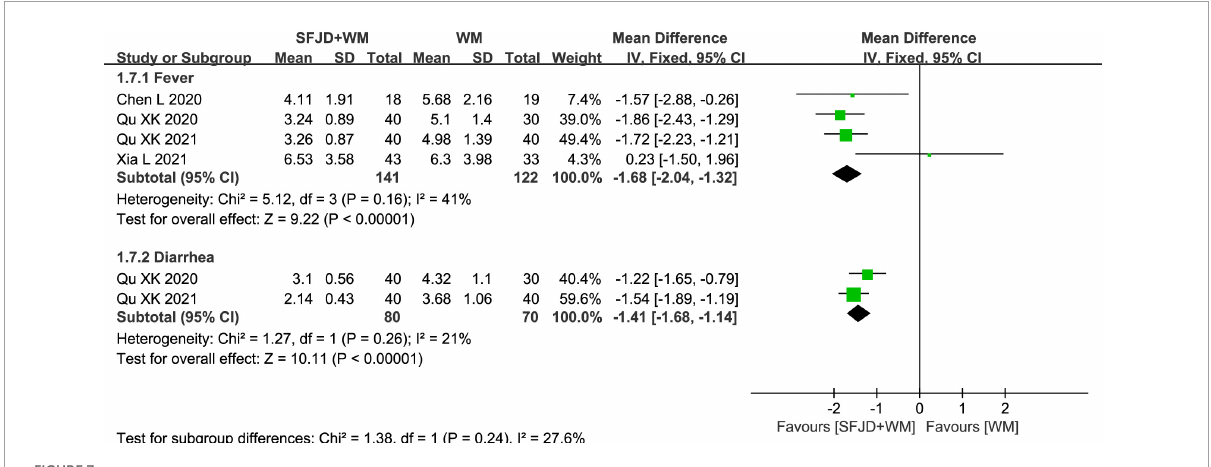
( MD = 2.15%, 95%CI: 0.98–3.32 , P = 0.0003, non-RCT) levels better than WM treatment ( Supplementary Table 9